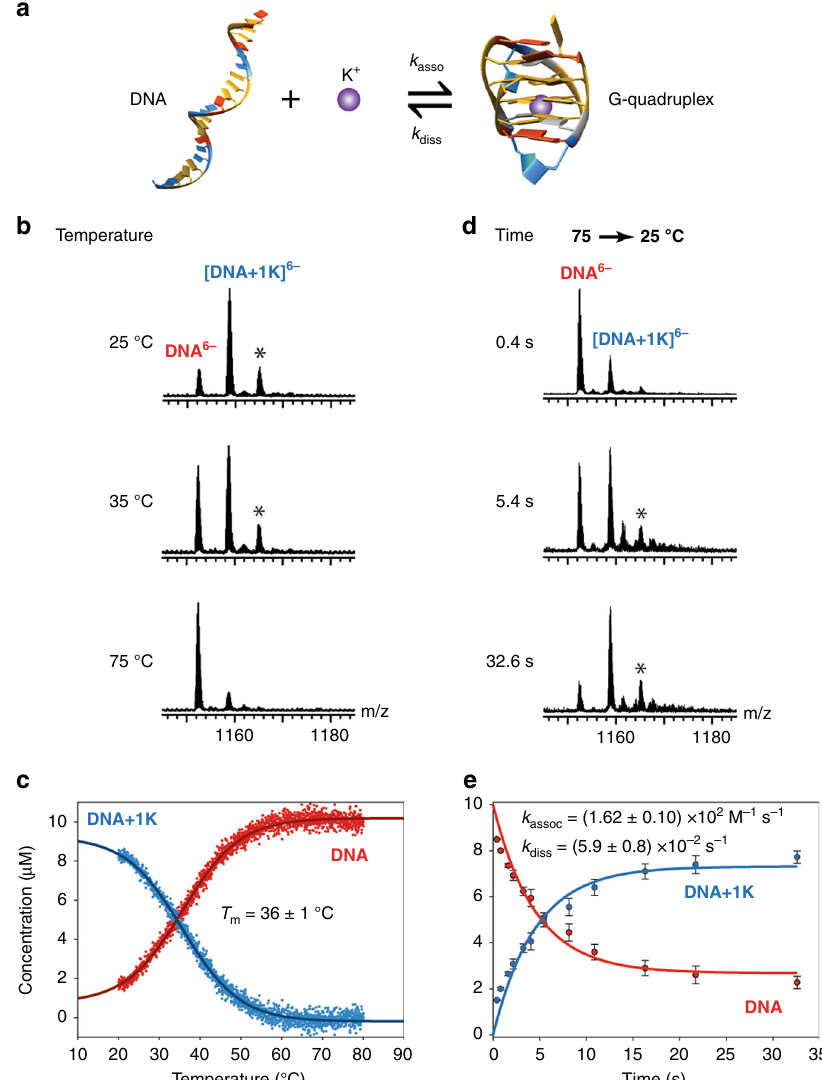
Fig. 2 Kinetics of G-quadruplex formation. a Representation of the chemical equilibrium of binding of K + to the DNA sequence 22CTA (d(A (GGGCTA) 3 GGG), PDB ID: 2KM3 45 ). b , c Thermal denaturation of 22CTA – K + , monitored by MS (10 µ M DNA in 100 mM TMAA and 1 mM KCl). d , e Kinetics recorded using the T -jump ESI source (jump from 75 to 25 °C). The mass spectra are magni fi ed views of the 6- charge state. The peaks labeled with a star correspond to a nonspeci fi cally bound K + ion. c , e Quanti fi cation of the species taking into account nonspeci fi c adducts as described previously 47,48 . The 5- and 6- charge states were averaged. The vertical error bars in e are the standard deviation obtained from the quanti fi cation on different charge states (5- and 6-, n = 2). The reproducibility of the experiment is discussed in the Discussion section. The errors on the rate constants are the standard deviations from the fi tting. Source data are provided as a Source Data fi